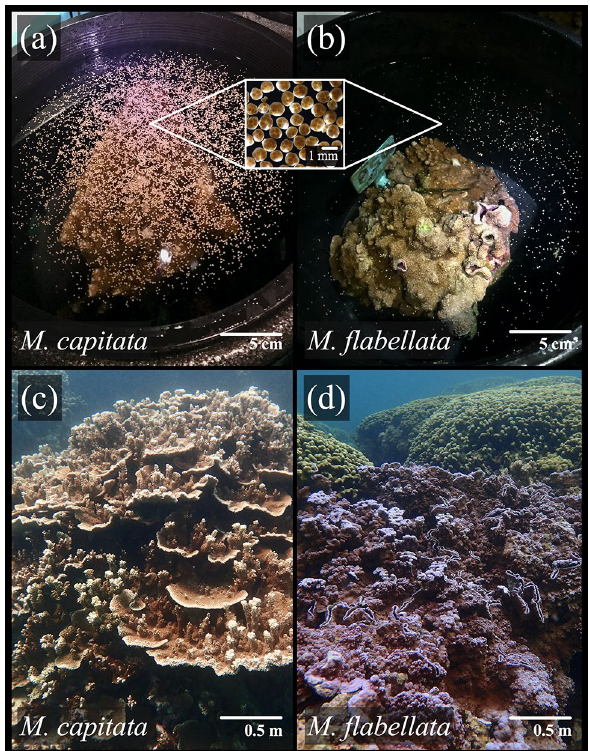
Figure 2. Release of egg-sperm bundles in M. capitata and M. flabellata. ( a ) Typical spawn from M. capitata with egg-sperm bundles covering the surface of the container (approximately 8,000 bundles). ( b ) Example of a “heavy” spawn from M . flabellata with ~ 400 egg-sperm bundles released. Over two summers, no colonies of M . flabellata released as many bundles from a heavy spawn in a single night compared to a typical spawn characteristic of M. capitata . Inset: close-up of egg-sperm bundles before breaking apart and releasing eggs and sperm to water column. ( c ) Montipora capitata and ( d ) M. flabellata in Kāne ʻ ohe Bay. All photographs by first